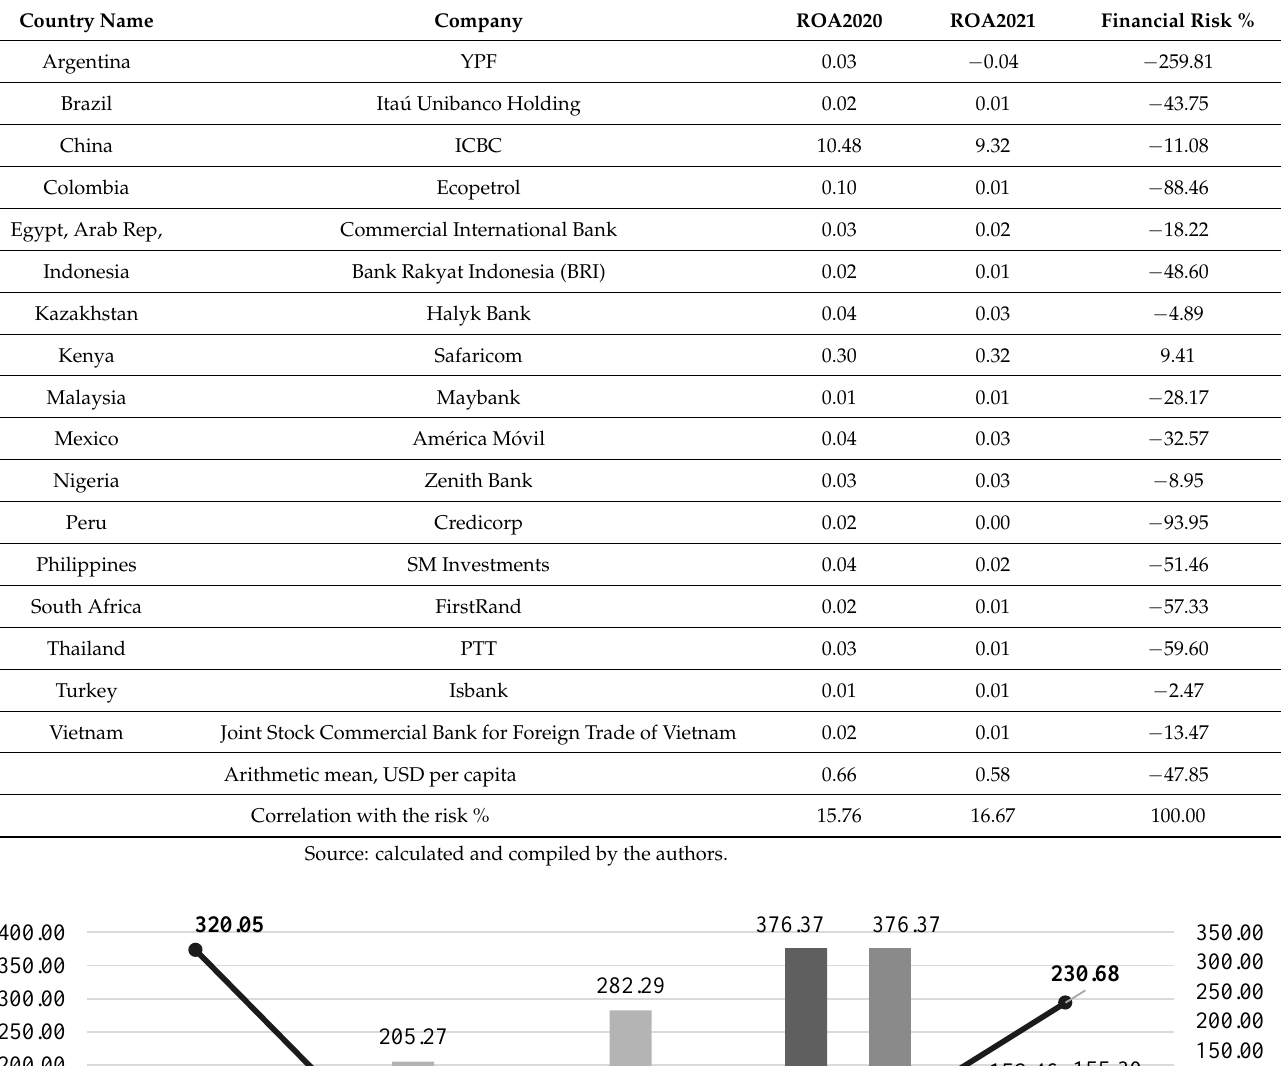
Table 4. Assessment of the financial risk of companies in 2021.